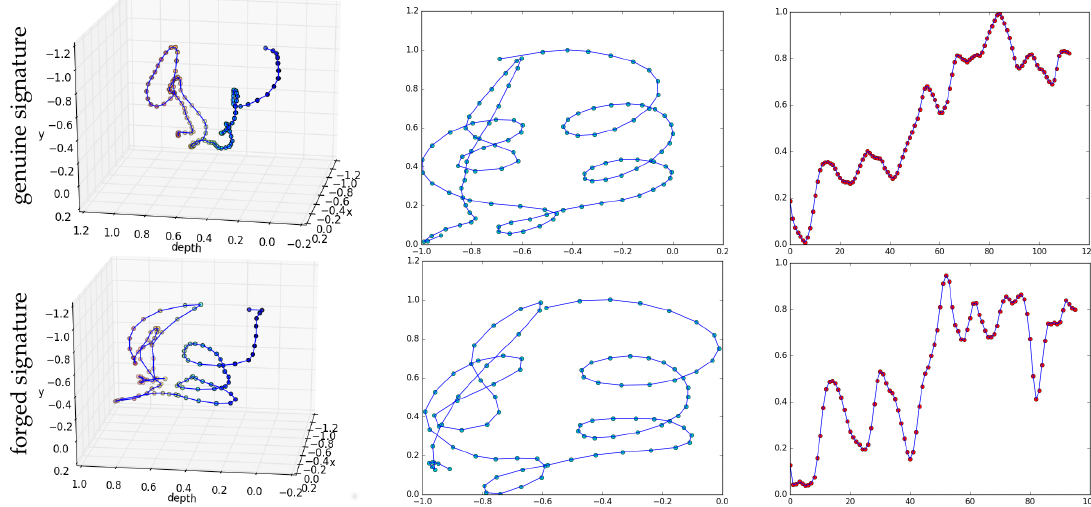
Figure 7. Comparison of spatial and depth patterns of the genuine and the corresponding forged signature. The top row shows a sample of a genuine signature and its corresponding spatial and depth patterns and the bottom one shows the respective forged signature. The color change shows the variation in depth pattern (3D view in the first column). Clearly, the depth pattern of the forged signature is different than the original one, although spatially they seem to be close.